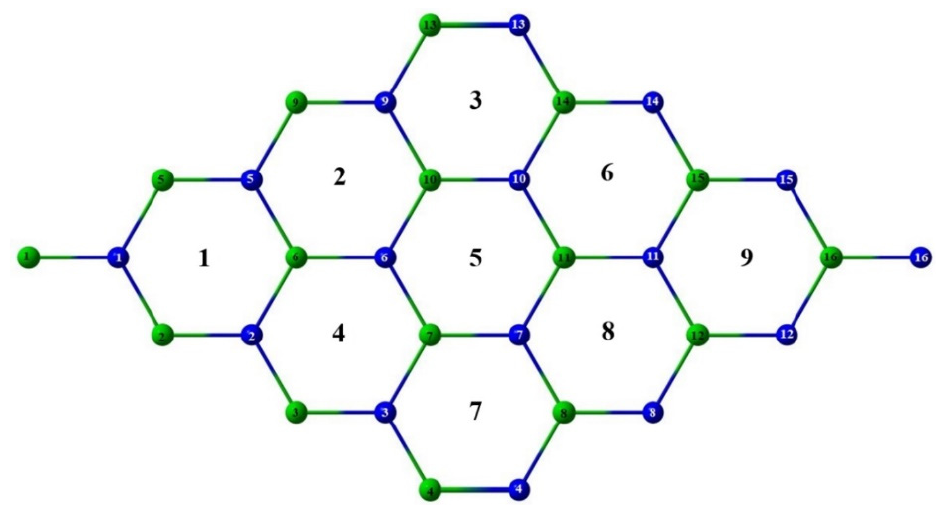
Figure 1. Sheet structure. Green: Ga/In. Blue: N.